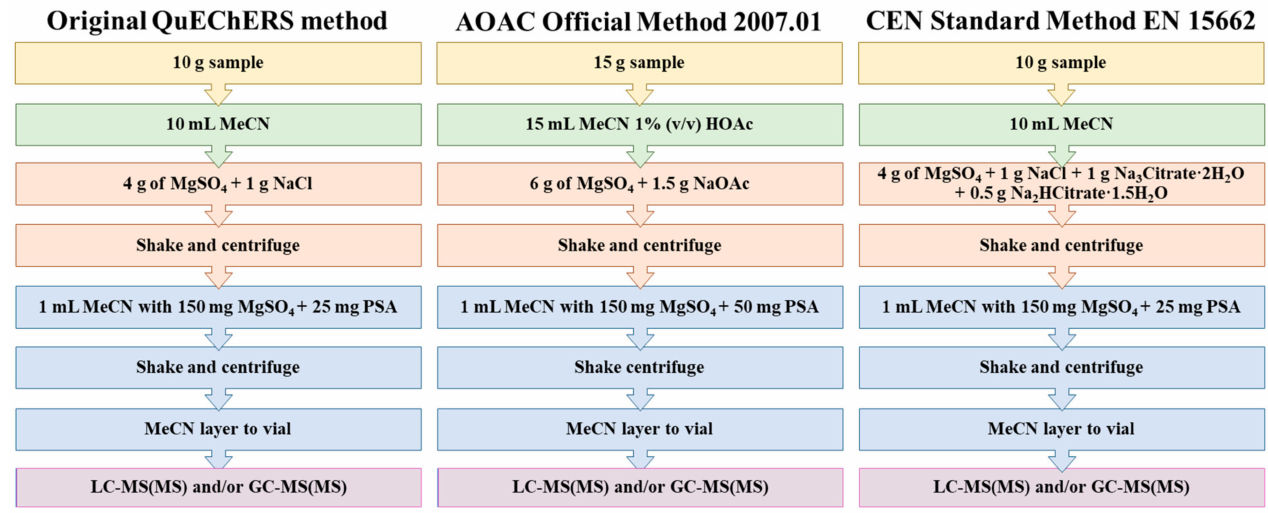
Figure 1. Diagram of the three primary QuEChERS methods based on [5,7,8],